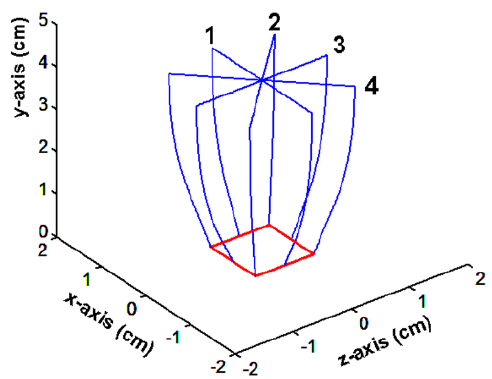
Figure 2. Demonstration of the angular rotation of the 2 ‐ D cross ‐ sections to produce the rotationally asymmetrical compound parabolic concentrator (RACPC) [33]. asymmetrical compound parabolic concentrator (RACPC)